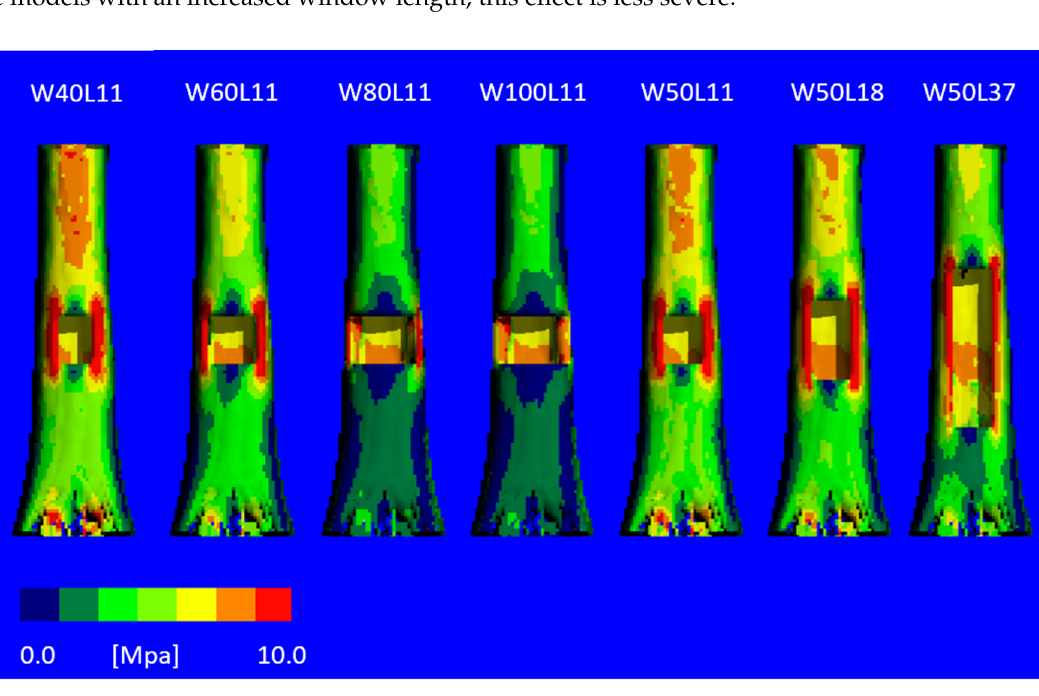
Figure 6. The von Mises stress distribution for virtually created cortical defects with varying sizes, for one of the bone samples. With an increasing width of the defect, the high stresses are more concentrated in the corners of the defects. Defects 3 and 4 show low stresses below the defect and high stresses in small areas, whereas the narrow defects show a more homogeneous distribution of the stresses.